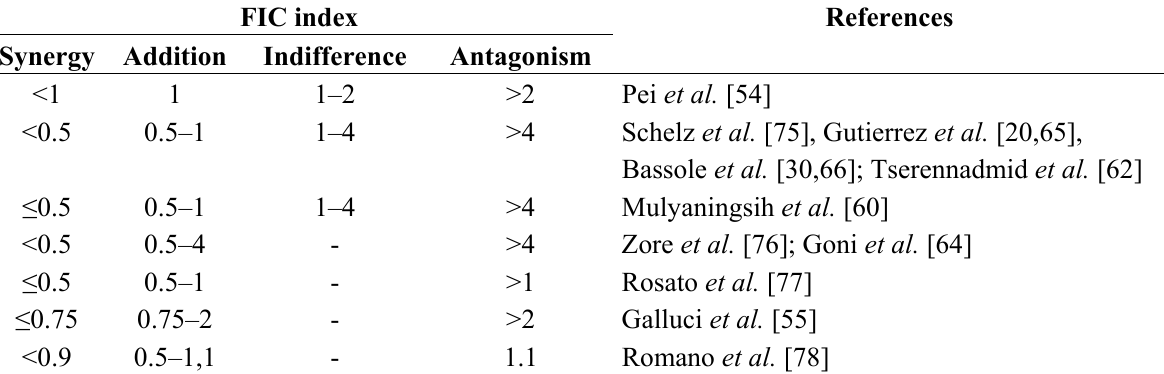
Table 2. Fractional inhibitory concentration (FIC) index used to determine the type of